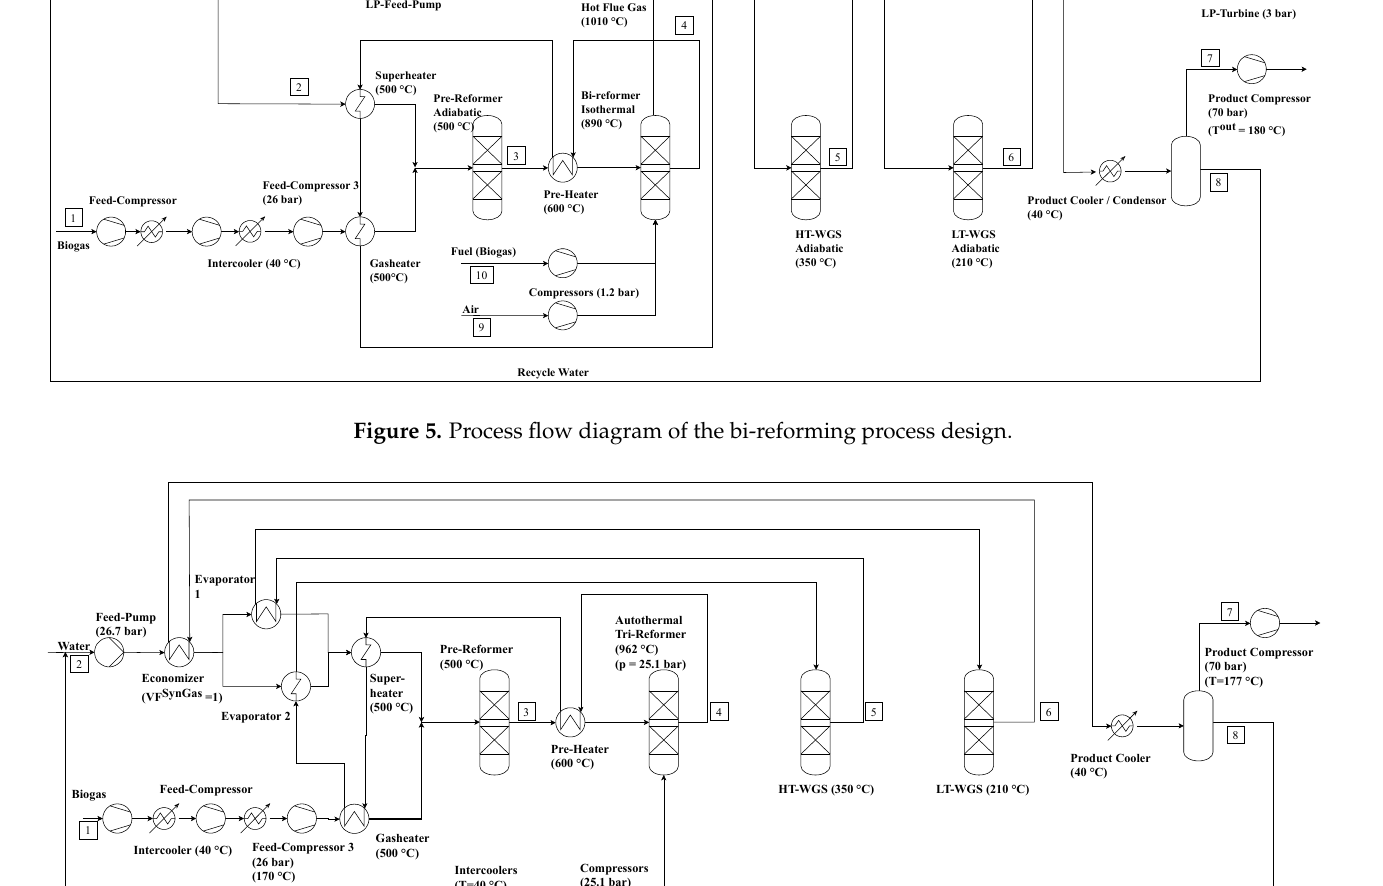
Figure 5. Process flow diagram of the bi-reforming process design.